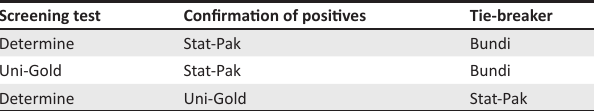
TABLE 1: Algorithm adopted in 2007 for HIV rapid testing in Nigeria. Screening